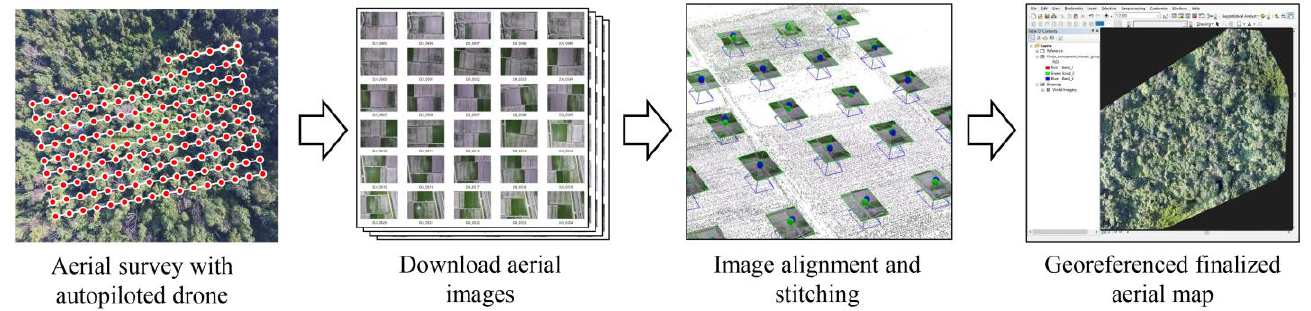
Figure 12. Drone operation and image analysis protocol used in this study.